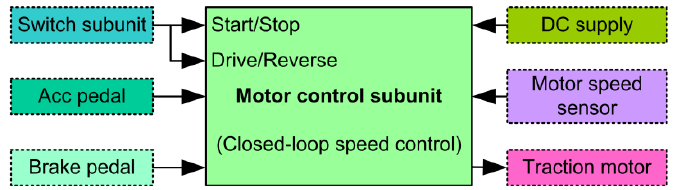
Figure 7. Block diagram of motor control subunit.